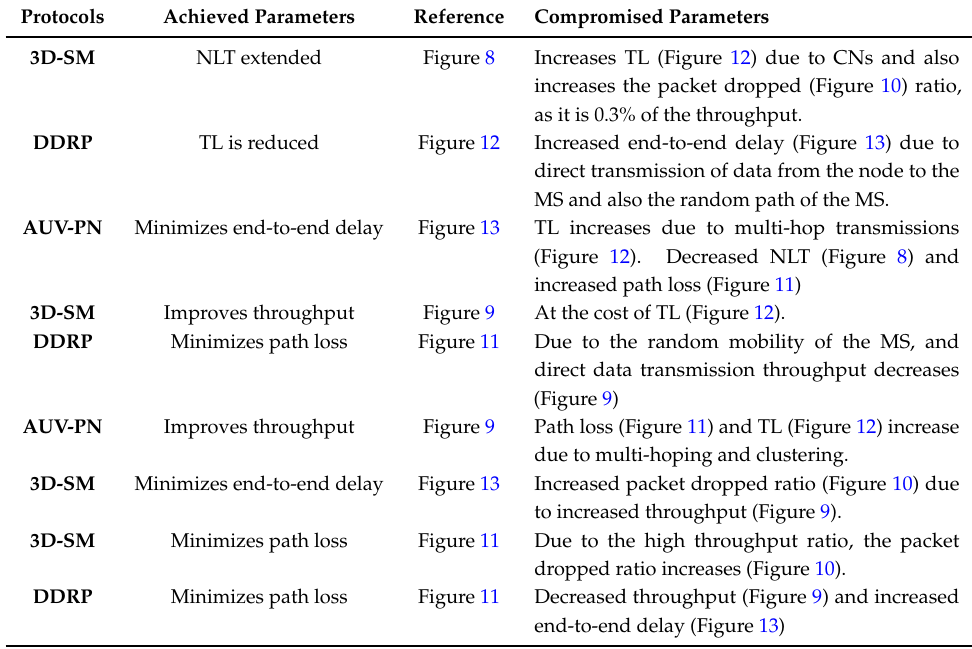
Table 4. Performance trade-offs made by the protocols. DDRP, data-driven routing